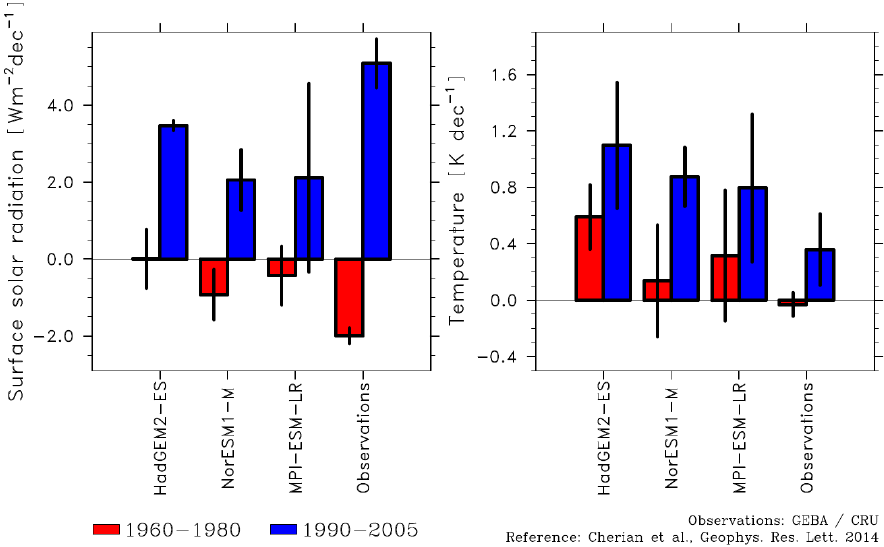
Figure 6. Linear trends in (left) surface solar radiation and (right) near-surface temperature increase per decade over continental Europe from the “historical” simulations in the CMIP5 archive contributed by previous versions of three ECLIPSE ESMs. The period 1960–1980 is shown in red, the period 1990–2005 in